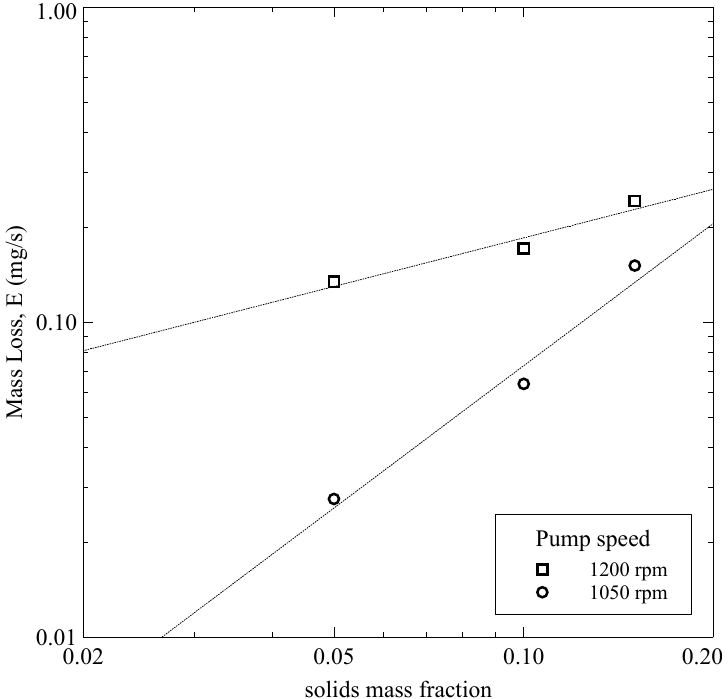
Figure 8. The relationship between wear rate and solids concentration for different rotational speeds (1050 rpm and 1200 rpm) in log–log axes. Table 2. The effect of solids concentration and flow rate on wear rate.